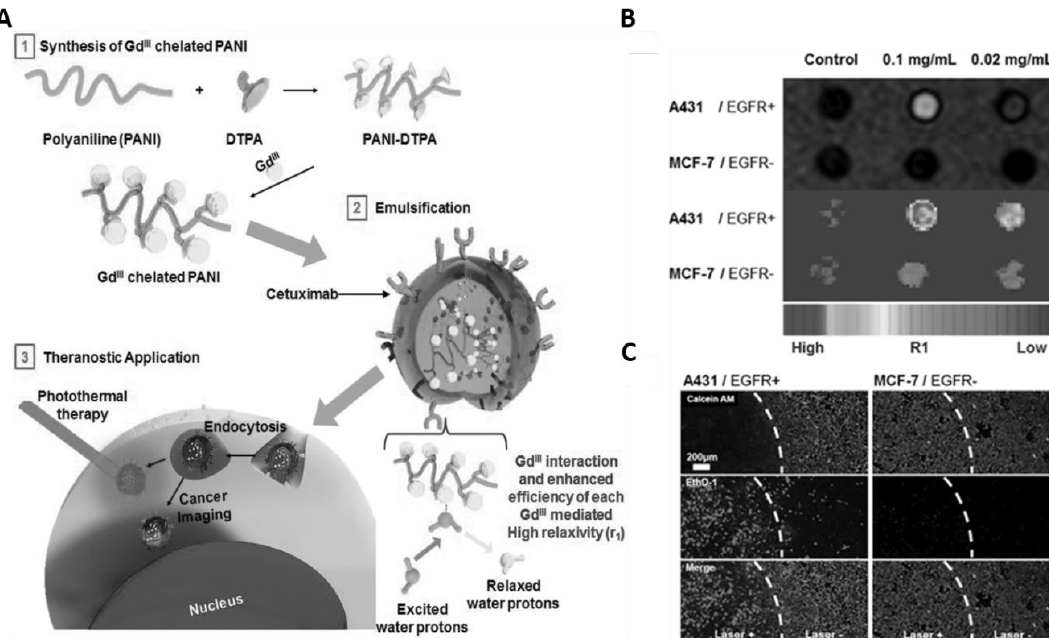
Figure 3. ( A ) Schematic illustration for the preparation of Gd (III)-loaded polyaniline nanoparticles (GPAPs) and their application as theranostic agent for epithelial cancer. ( B ) T 1 -mapped and respective color-mapped MR images of A431 (EGFR+) and MCF-7 (EGFR−) cell lines after treatment with different amount of GPAPs. ( C ) Fluorescence microscopic images of A431 (EGFR+) and MCF-7 (EGFR−) cells stained with Calcein AM and ethidium homodimer-1 (EthD-1) after treatment with GPAPs followed by NIR laser irradiation for 10 min (808 nm, 10 W cm −2 ). White-dotted curves represent the location of the laser beam (images are reproduced from [43] with the copyright permission from WILEY-VCH Verlag GmbH & Co.).